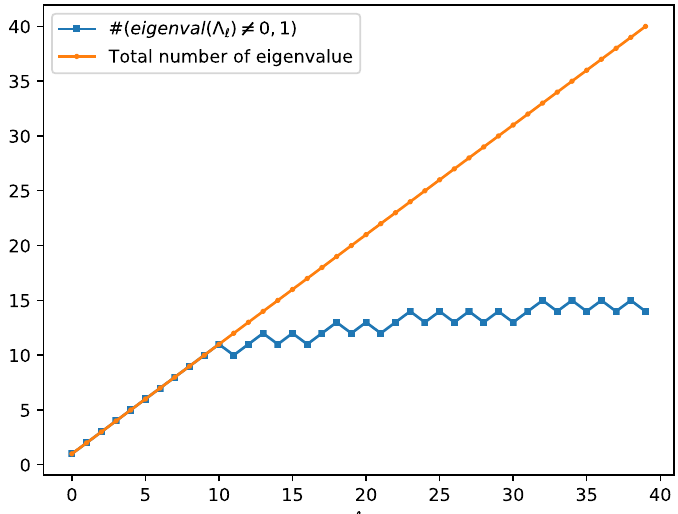
Figure 11: In blue the number of eigenvalues of Λ (cid:96) that are not 0 or 1 up to machine precision, in orange the total number of eigenvalues of Λ (cid:96) in the ground state of a hopping Hamiltonian with N = 500. When the dimension of the partition is (cid:96) > 10 the entanglement grows logarithmically and the number of eigenvalues equal to 1 or 0 starts growing